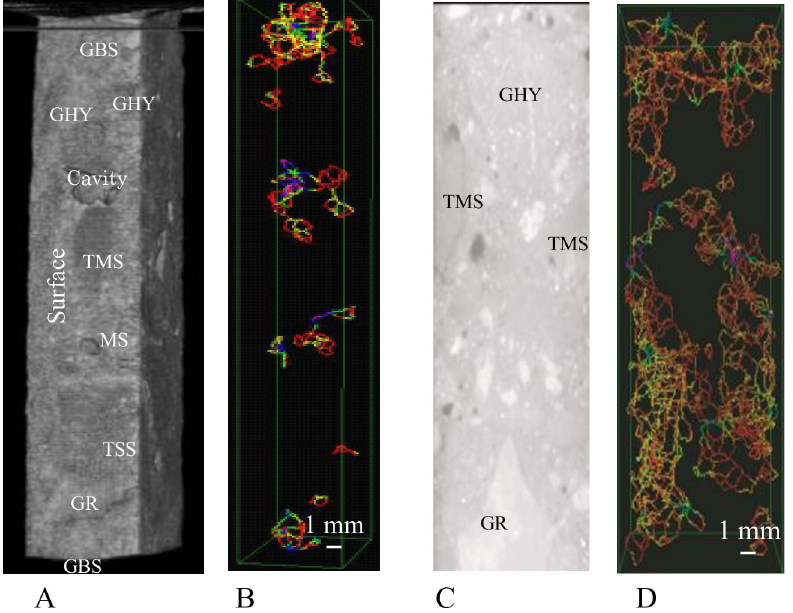
Fig 4. Cracks in the damaged aggregate and crack distribution of three-dimensional cracks of the samples in the first (0–2.5 cm) and second layers (3–5.5 cm).